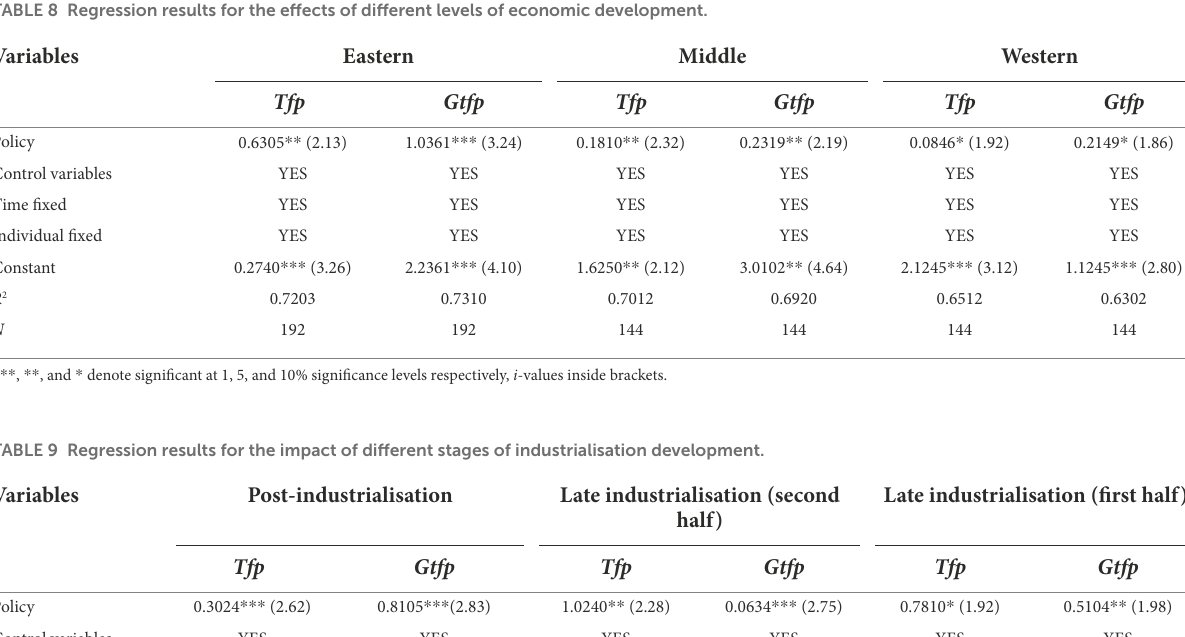
TABLE 8 Regression results for the effects of different levels of economic